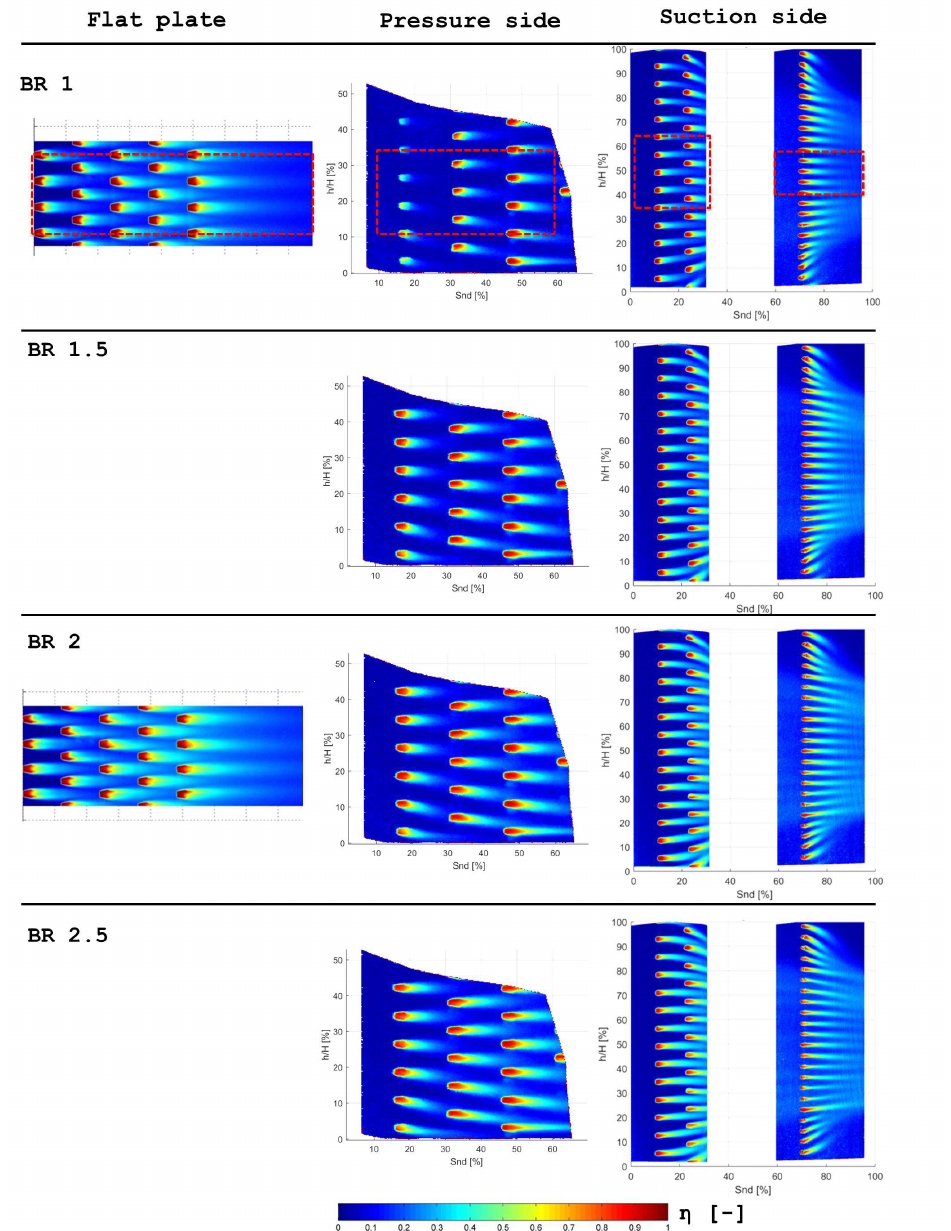
Figure 5. Adiabatic effectiveness contour